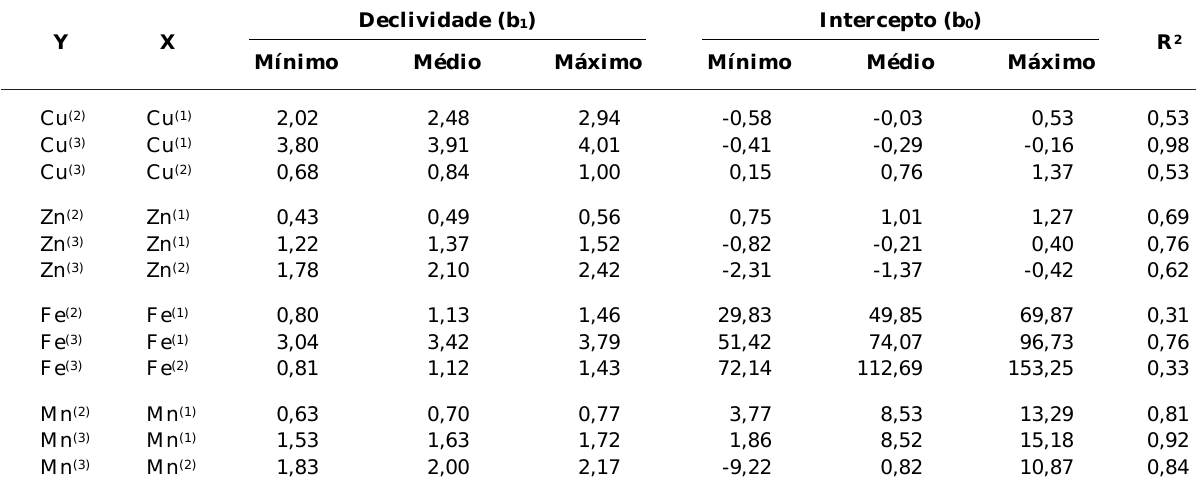
X) estimados entre os três tipos de 1